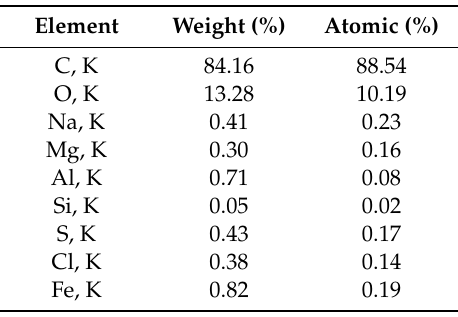
Table 4. Multi-walled Carbon Nanotube (MWCNT) electrode Energy Dispersive Spectroscopy (EDS) result. Element Weight (%)